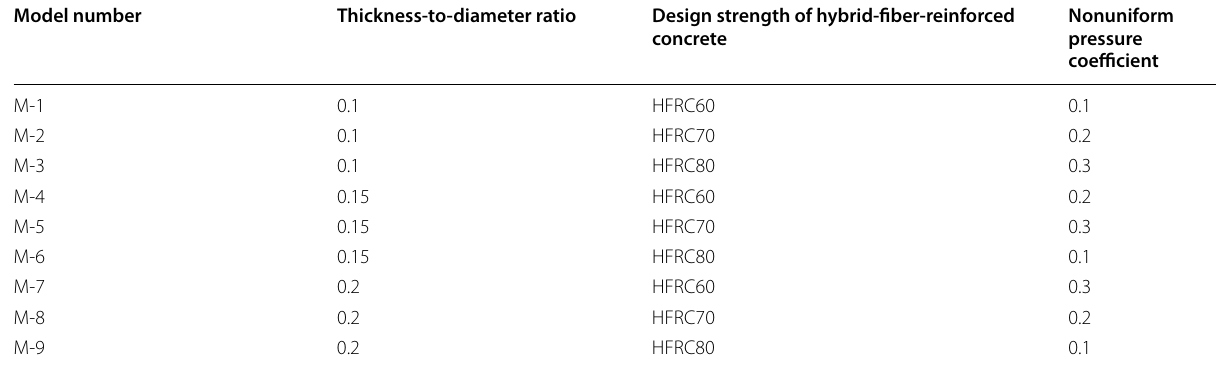
Table 5 Orthogonal design table for numerical simulation.